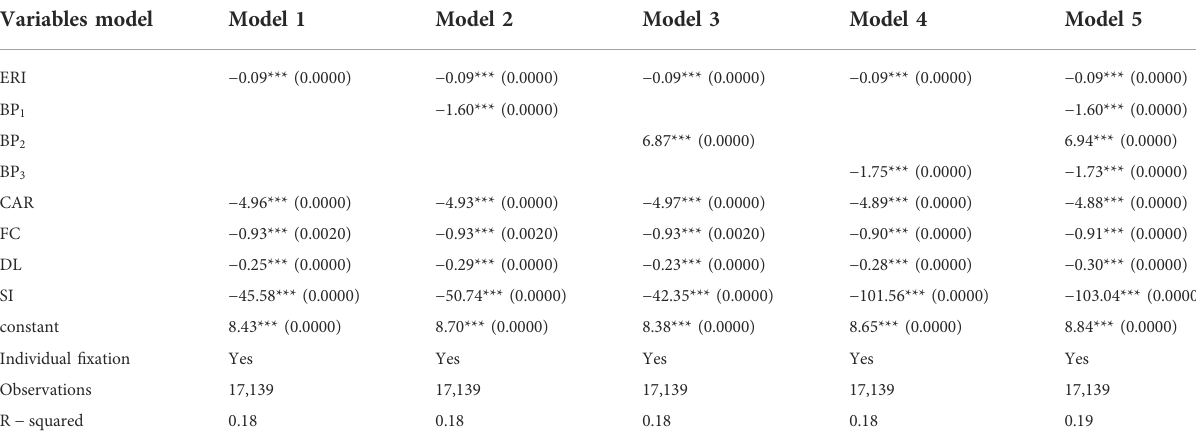
TABLE 5 Regression results of Taiwan-funded